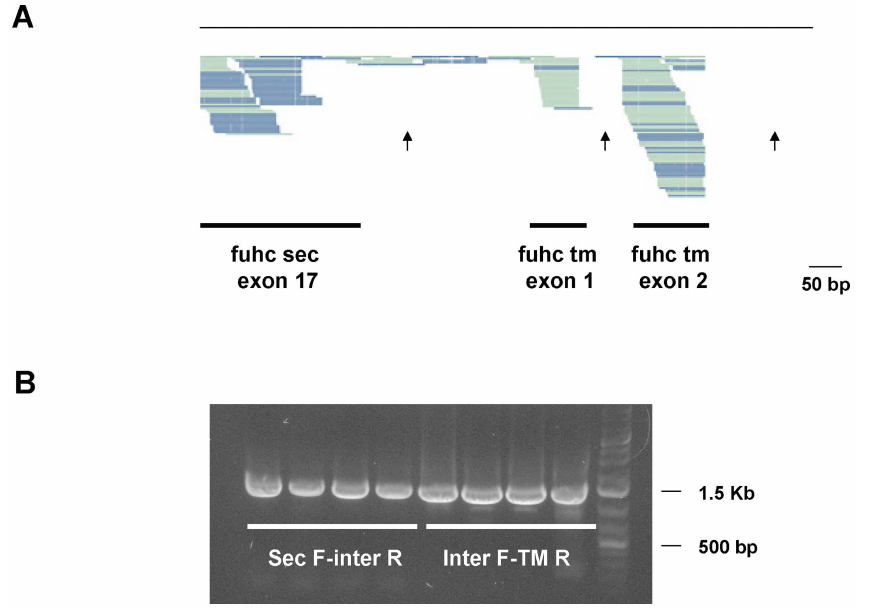
Figure 4. A stable transcript encoding both fuhc sec and fuhc tm can be detected by mRNA-seq and RT-PCR. Top Alignment of Illumina mRNA-seq reads from a single genotype to the fuhc genomic region spanning from fuhc sec exon 17 to the intron following fuhc tm exon 2. Multiple sequences span the 227bp region between the genes (arrow in center), however, there are no aligned sequences in introns between fuhc tm exons 1 and 2, or 2 and 3 (right two arrows). Bottom RT-PCR on cDNA isolated from 4 wild-type individuals. The right 4 lanes are from the exon 2 of fuhc sec to the intergenic region, the left 4 lanes are from the intergenic region to the exon 13 of fuhc tm . Only single products are amplified using these primers.